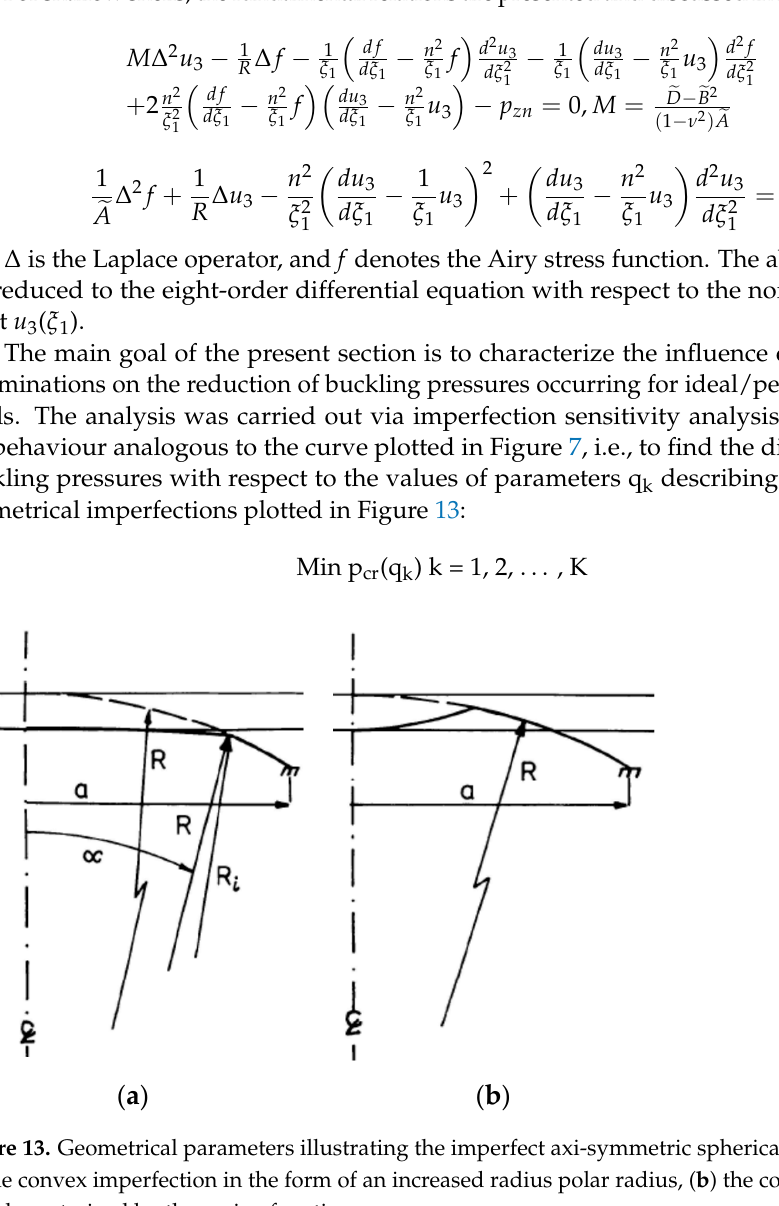
Figure 12. Forms of the loss of stability of delaminations in spherical shells.